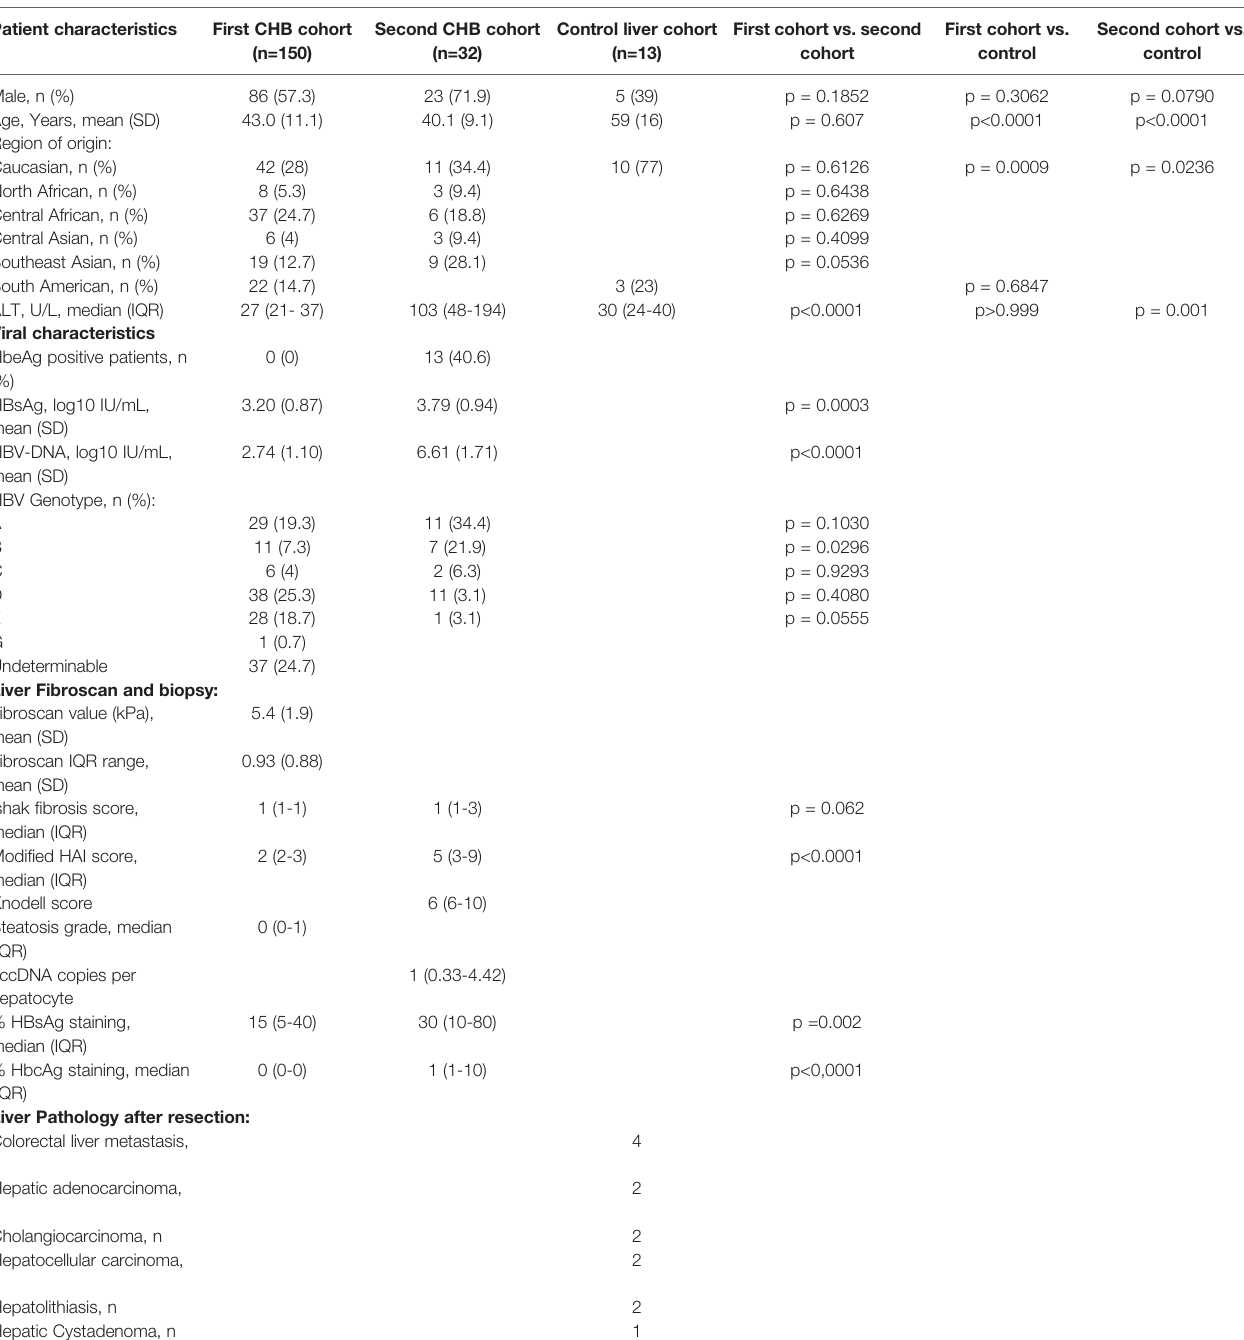
TABLE 1 | Baseline characteristics of the fi rst CHB patient cohort (n=150), second CHB patient cohort (n=32) and liver controls (n=13). Patient